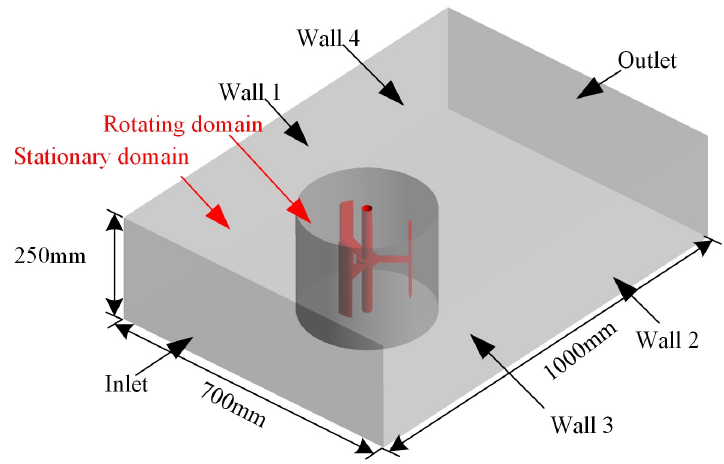
Figure 1. Computation